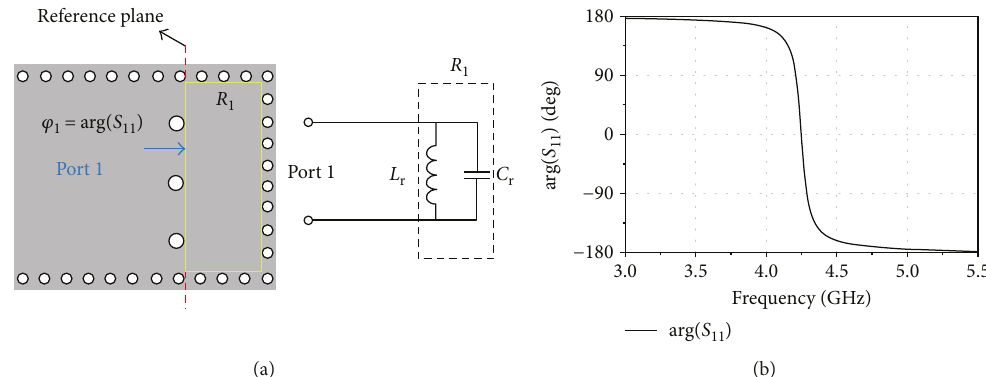
Figure 5: Illustration of analysis model and the results. (a) Analysis model of an end shorted resonator. (b) Simulated phase of S